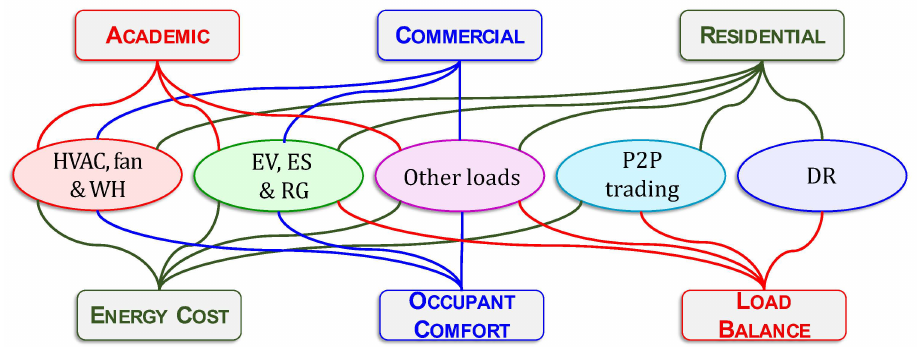
Figure 13. Building Types and Objectives. The building type and the RL’s objective of each ap- plication class. Note that the links are based on the existing literature covered in the survey. The absence of a link does not necessarily imply that the building type/objective cannot be used for the application class.